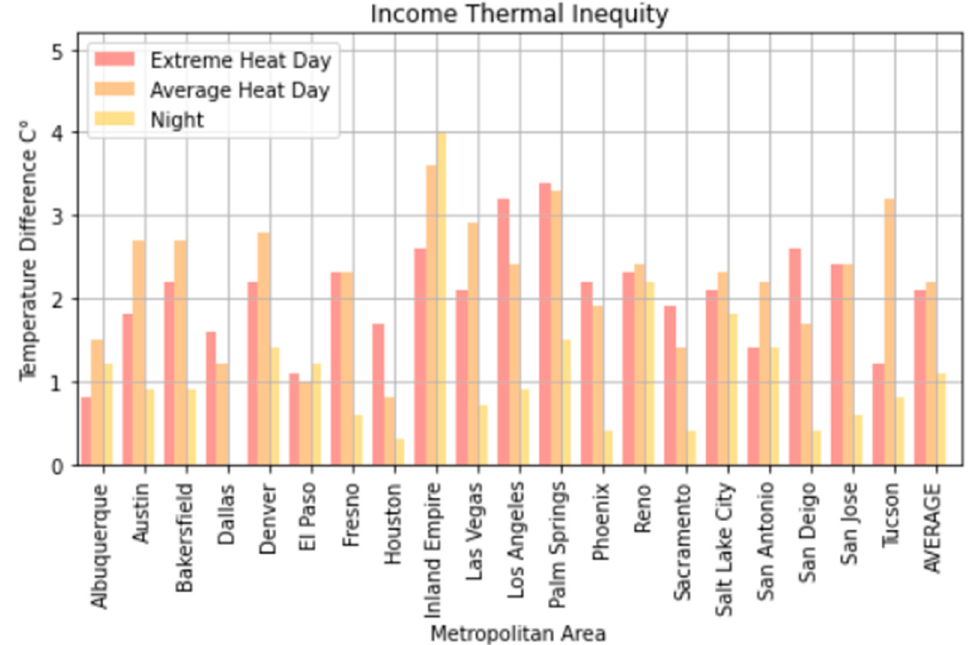
Figure 3. Income thermal inequity—a comparison of the temperature difference between the top 10 percentile of block groups and bottom 10 percentiles of block group based on income.